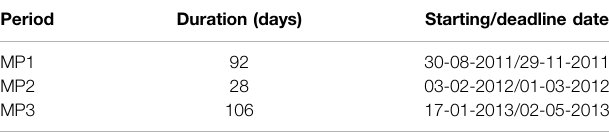
TABLE 1| Massbalance periodsretrieved forablation stakesused forSEB model validation at local point